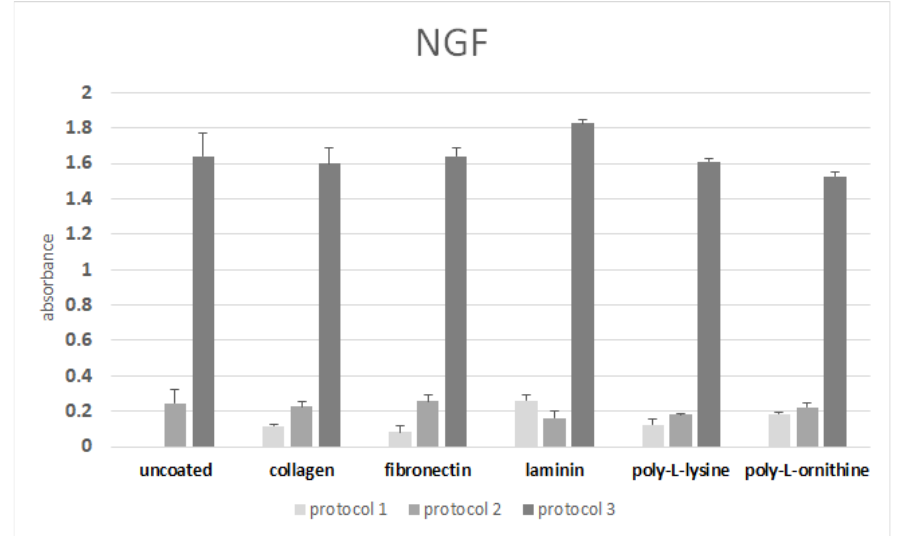
Figure 6. ELISA: expression of NGF after differentiation with Protocols 1, 2, and 3. The obtained values were not normalized to the total cell number.